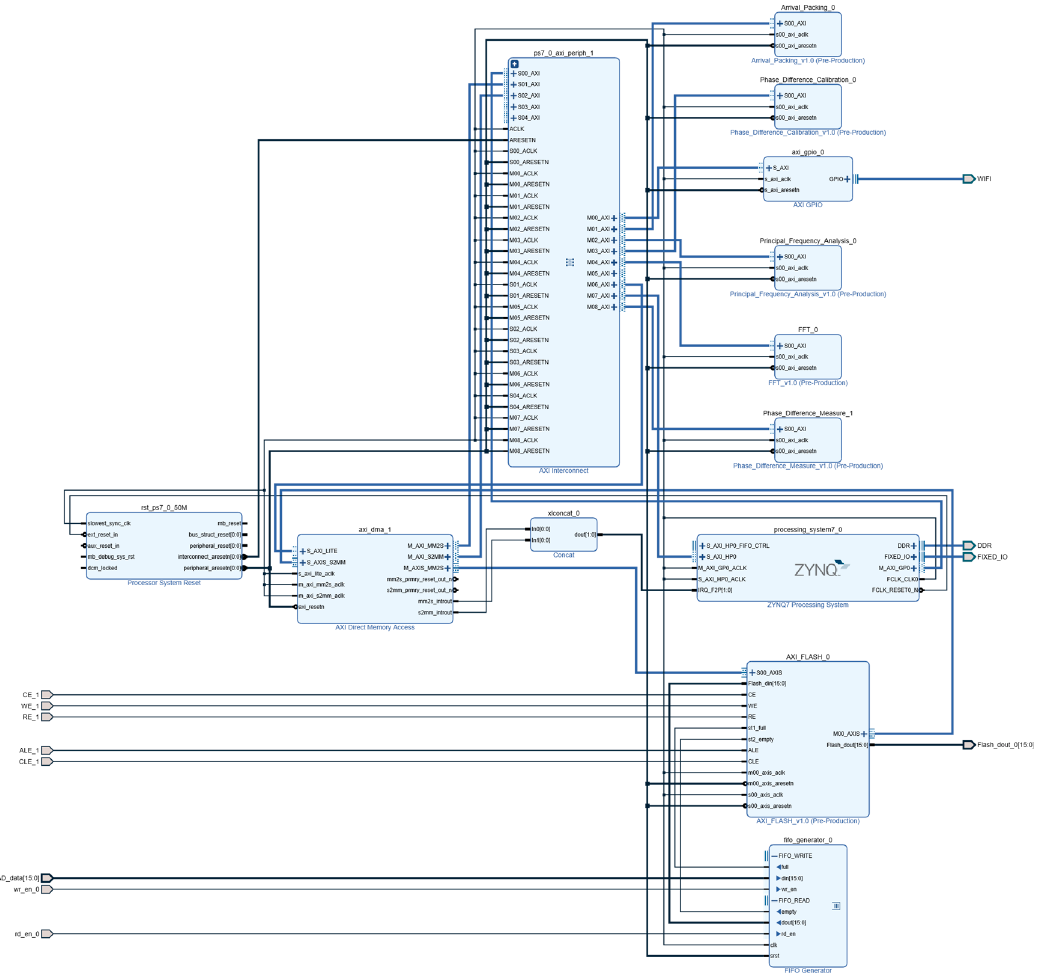
Figure 18. Detailed schematic of the top-level design.